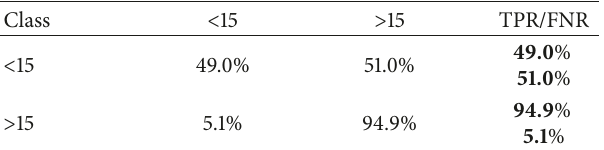
Table 3: Confusion matrix of Binary classification for Belisario using a BT. Rows represent the true class and columns represent the predicted